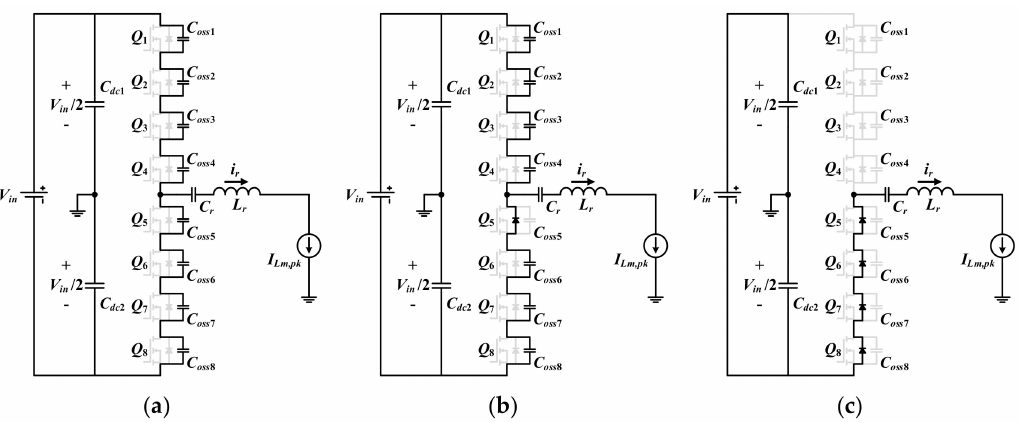
Figure 6. Equivalent circuits during turn-on switching transient: ( a ) Interval 1; ( b ) Interval 2; ( c ) Interval 3.